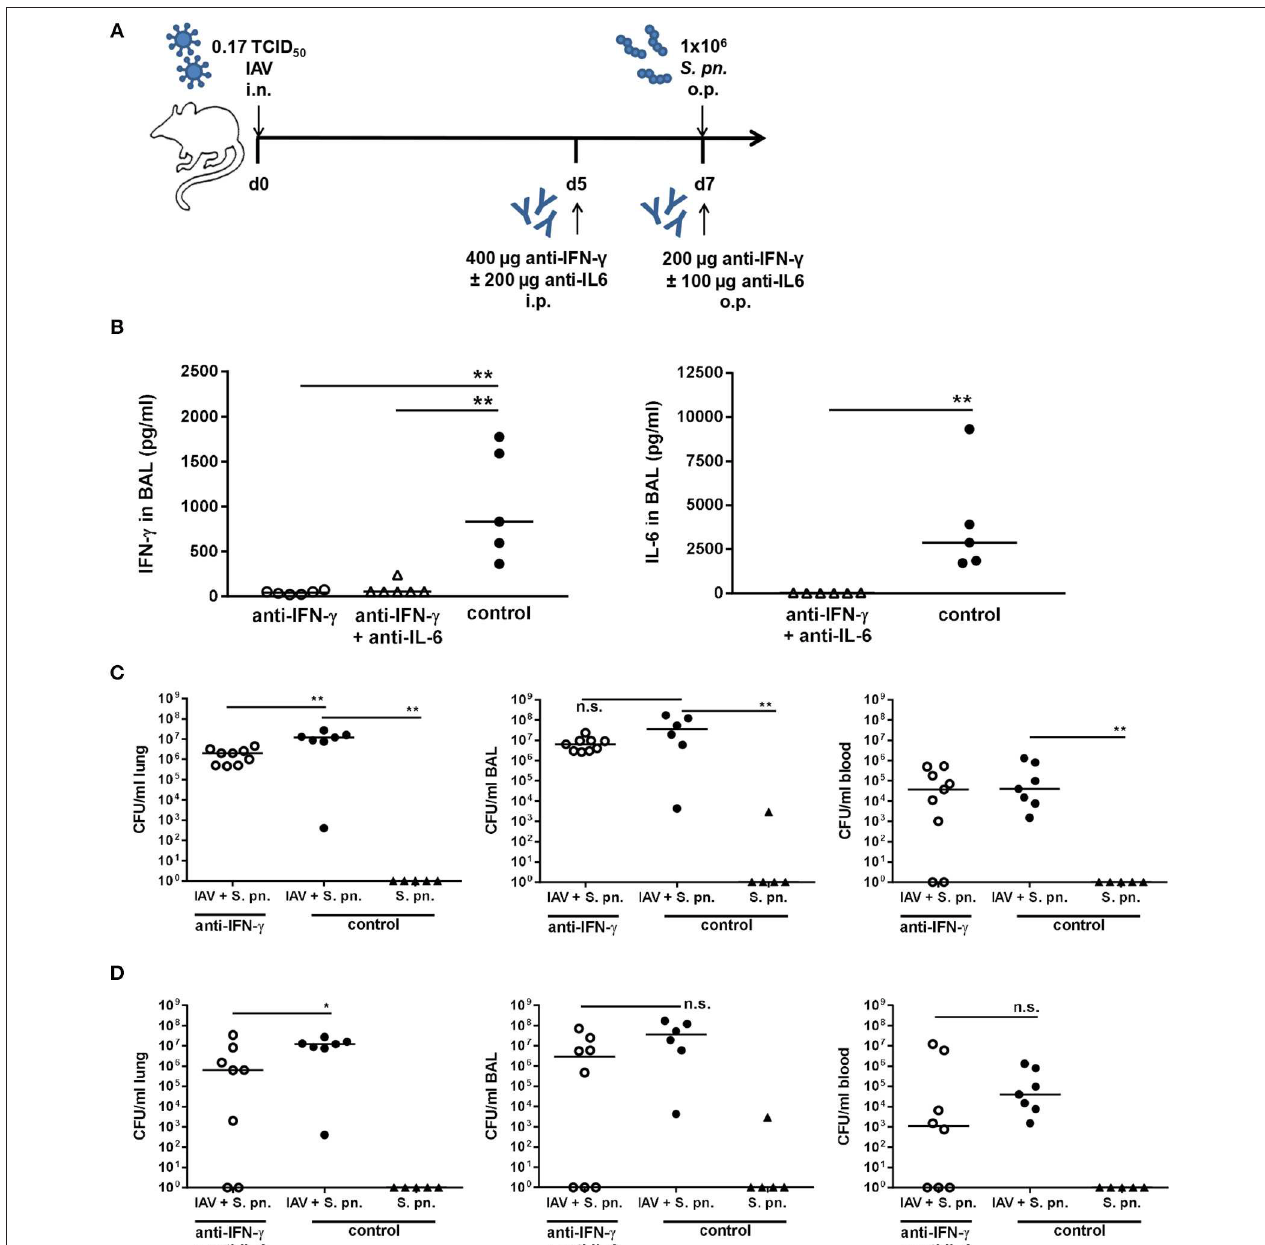
FIGURE 6 | Neutralization of IFN- γ and double-neutralization of IFN- γ and IL-6 during co-infection with 0.17 TCID 50 IAV and 1 × 10 6 CFU S. pn. significantly reduced the lung bacterial burden. Mice were infected intranasally (i.n.) with 0.17 TCID 50 IAV or left uninfected on day 0. On day 5, mice were intraperitoneally (i.p.) injected with anti-IFN- γ antibody alone or in combination with anti-IL-6 antibody. On day 7, mice were treated with anti-IFN- γ antibody alone or in combination with anti-IL-6 antibody and at the same time infected with 1 × 10 6 CFU S. p.n. oropharyngeally (o.p.). The control groups were infected likewise and treated with an isotype IgG antibody. (A) Experimental setup. (B) IFN- γ and IL-6 protein levels in bronchoalveolar lavage (BAL) 24h post antibody treatment and S. pn. infection. (C,D) S. pn. bacterial counts in lung tissue, BAL and blood 24h post antibody treatment and S. pn. infection. Data are shown for individual mice and lines indicate the median/group. Co-infected, neutralizing antibody-treated were compared to co-infected, control-antibody-treated groups, and co-infected, control-antibody-treated groups were compared to single-infected, control-antibody-treated groups using the unpaired, one-sided Mann-Whitney test [n.s. = not significant ( p > 0.05), * p < 0.05, ** p < 0.01]. Data from co-infected mice are compiled from at least two independent experiments.